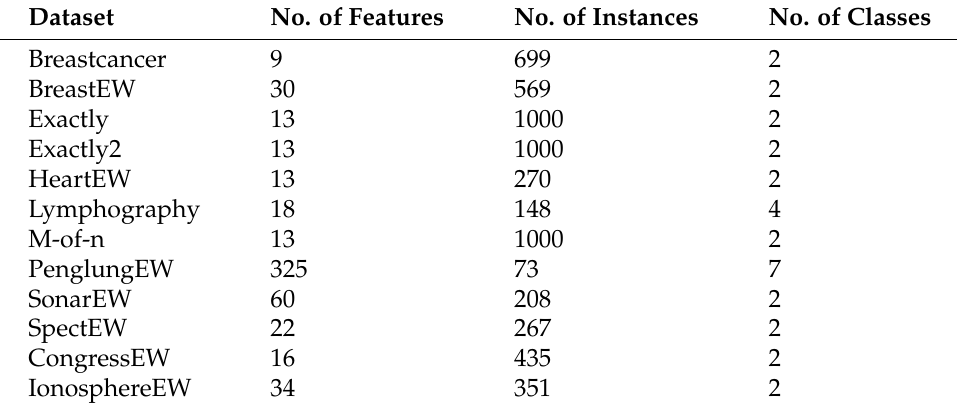
Table 2. List of employed